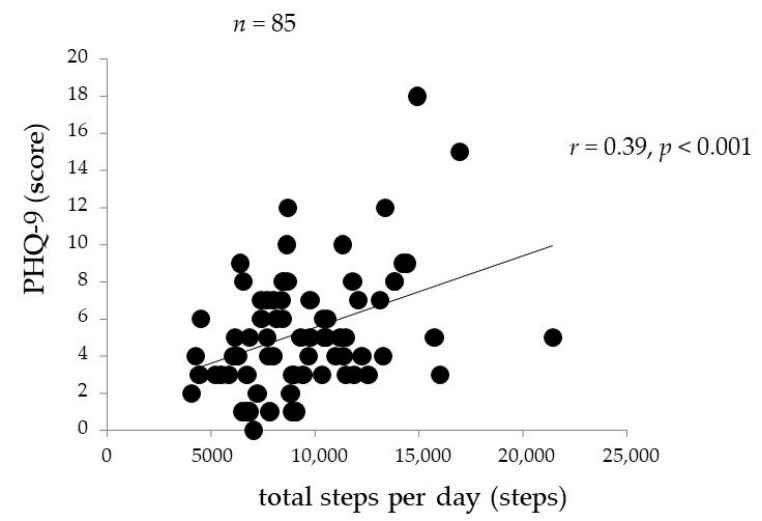
Figure 2. Relationship between PHQ-9 score and total steps per day.